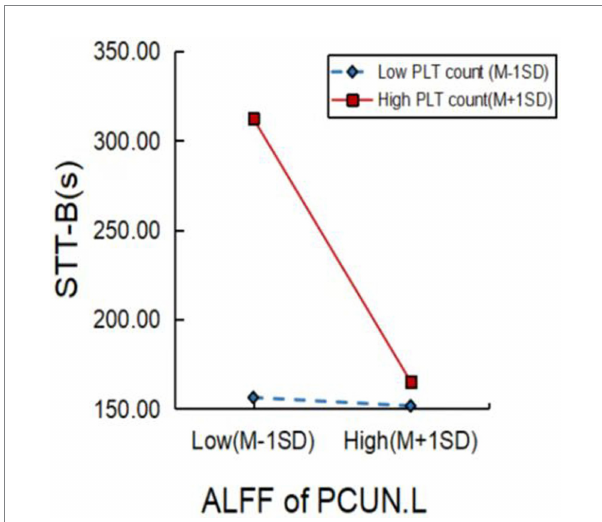
FIGURE 4 Platelet (PLT) count significantly moderated the relationship between brain function and cognitive performance in MCI patients. PLT, platelet; ALFF, amplitude of low-frequency fluctuation; PCUN.L, left precuneus; STT-B, shape trails test B; MCI, mild cognitive